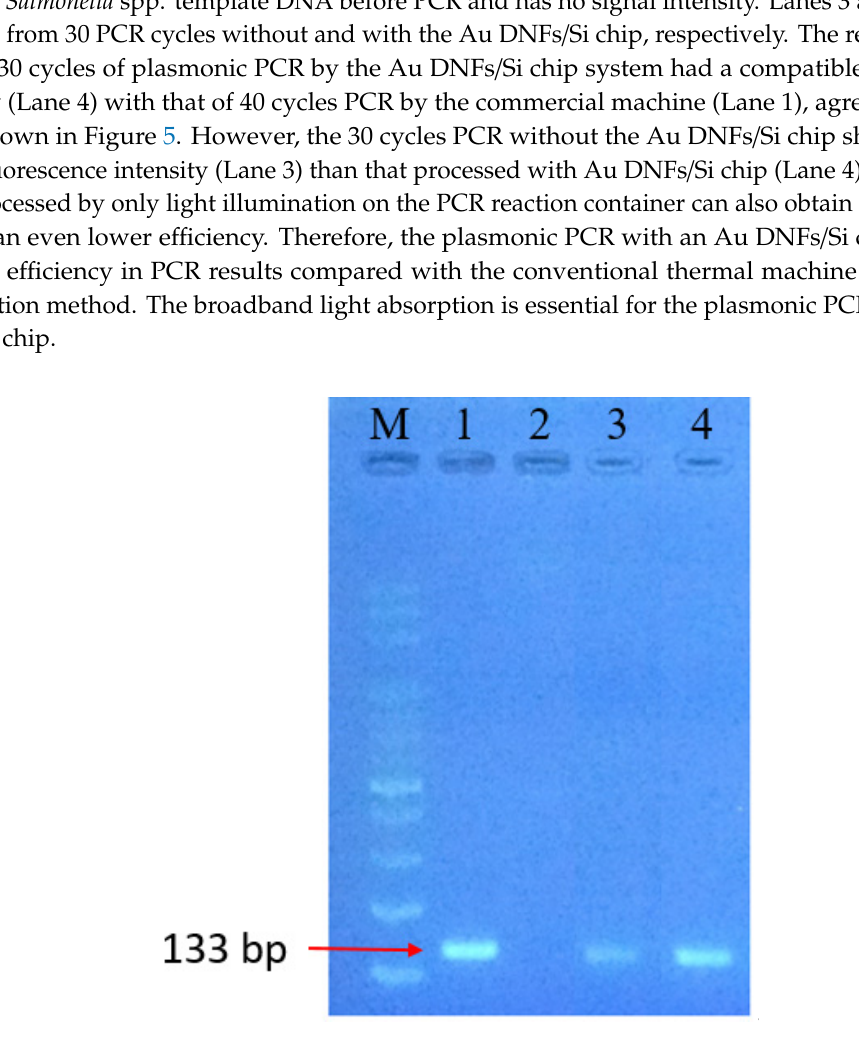
Figure 6. Gel electrophoresis of PCR products processed with and without the Au DNFs / Si chip. Lane M: 100-bp ladder marker, Lane 1: PCR product obtained using the commercial PCR thermal cycler, Lane 2: Salmonella spp. template DNA before PCR, Lanes 3: PCR product without the Au DNFs / Si chip, Lanes 4: PCR product with the Au DNFs / Si chip.